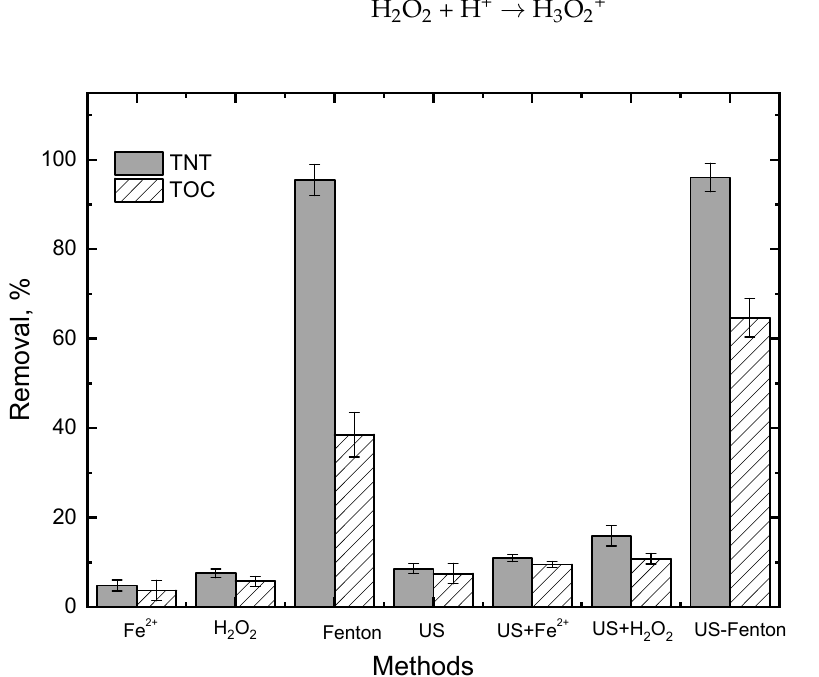
Figure 1. TNT and TOC removal by different AOP methods. Experimental conditions: (TNT) 0 = 30 mg/L, Initial pH = 3.0 ± 0.1, (Fe 2+ ) = 5 × 10 − 4 M, (H 2 O 2 ) = 5 × 10 − 3 M, (NaCl) = 10 − 2 M, US intensity = 8571 W/m 3 , Temperature = 25 °C, Reaction time = 60 min, US: ultrasound irradiation, US–Fenton: ultrasound–Fenton process.